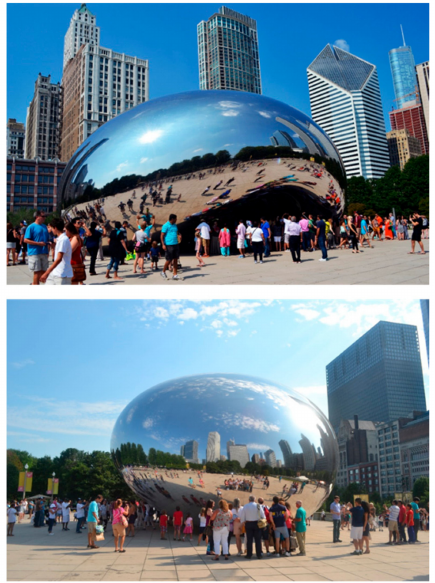
Figure 5. According to social media and participant surveys, the most photographed object in Millennium Park is the Cloud Gate sculpture. Participants admired the sculpture because it coalesces the city’s various parts, including public spaces, greenery, trees, shrubs, skyscrapers, people, the sky, and clouds. It also mirrors visitors’ movements and gestures. Further, it appears di ff erently when viewed from di ff erent locations: it looks like a sphere or a bean and whatever is in between (compare top and bottom photographs). Interestingly, the curvilinear geometry of the Bean contrasts well with the straight edges of skyscrapers in the background. Skyscrapers’ linear arrangement also promotes a sense of enclosure and complements the spaciousness of the plaza surrounding the Bean.